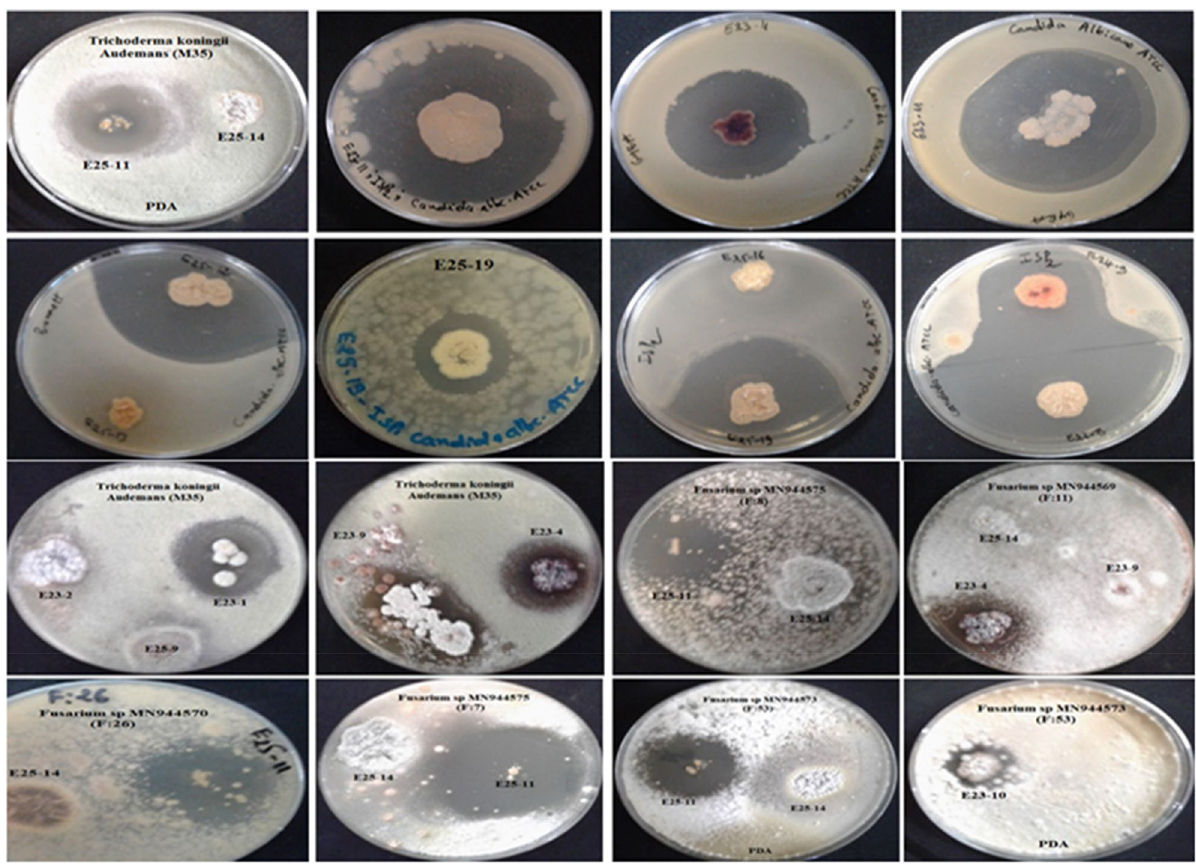
Figure 5. Antifungal activity of Actinomycetes pure isolates by the double layer method on ISP2 medium.